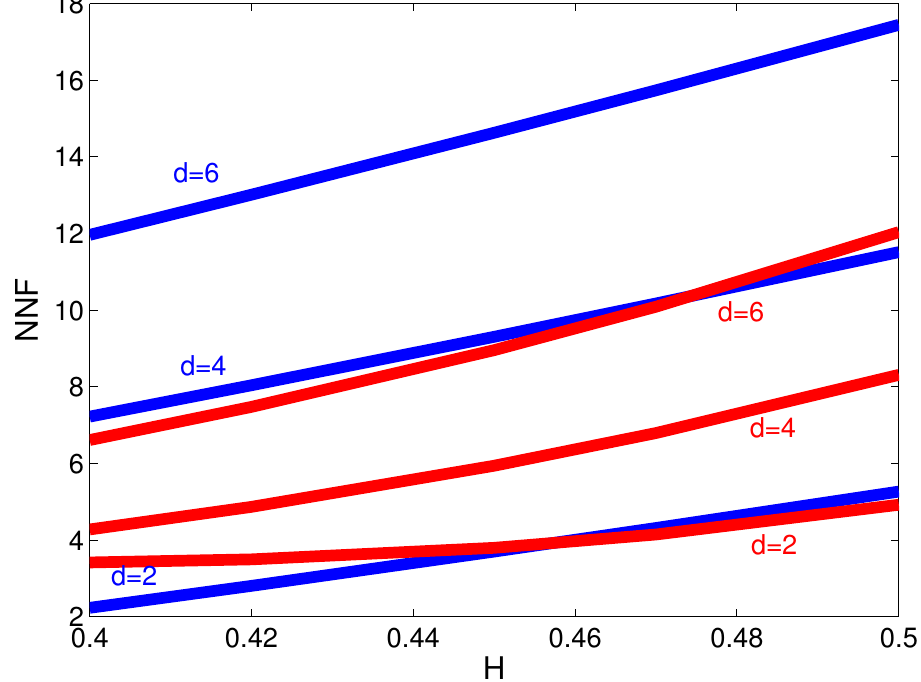
Figure 6. Plots of NNF for the models with hematocrit for the problem for semi-infinite interval: blue line—Modified Yeleswarapu model; red line—Quemada